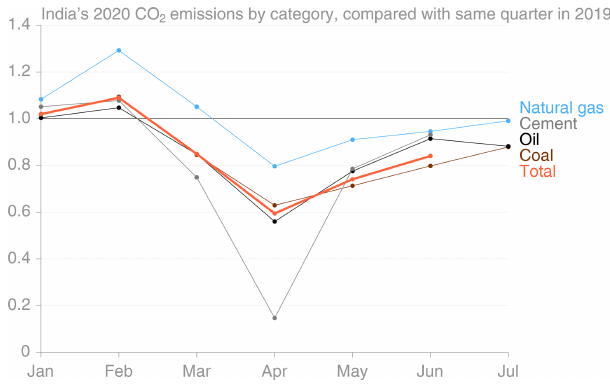
Figure 6. Quarter-on-quarter changes in CO 2 emissions by cate- gory during the first months of